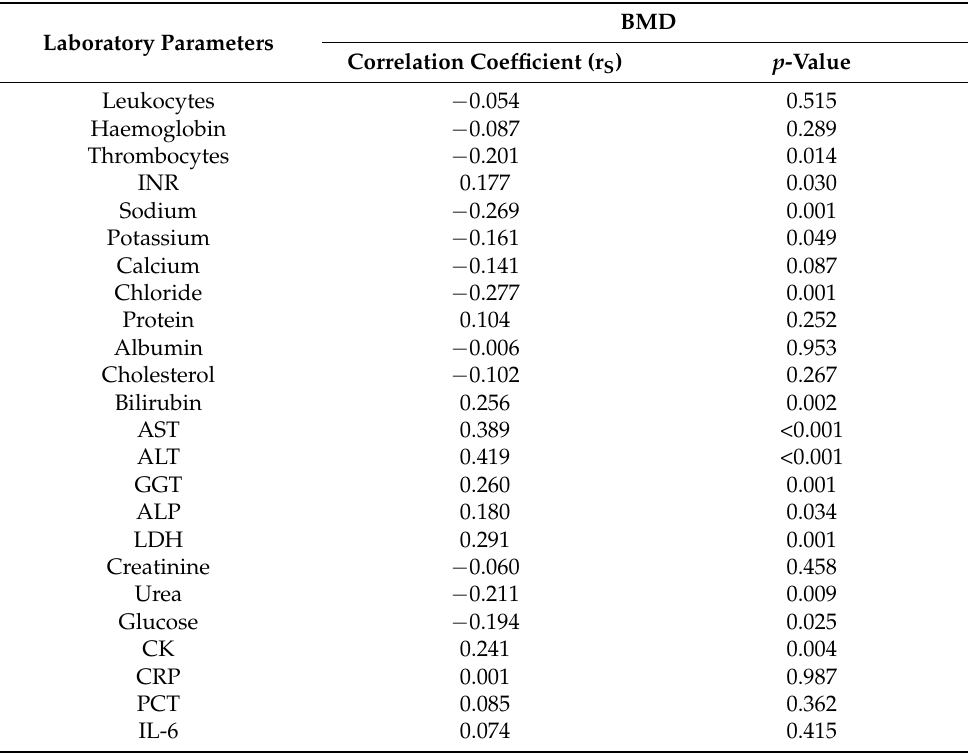
Table 2. Correlation analysis between BMD and various laboratory